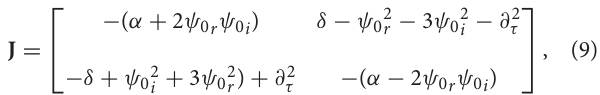
∂ t δ X J δ X , where J is the respective Jacobian. In the =